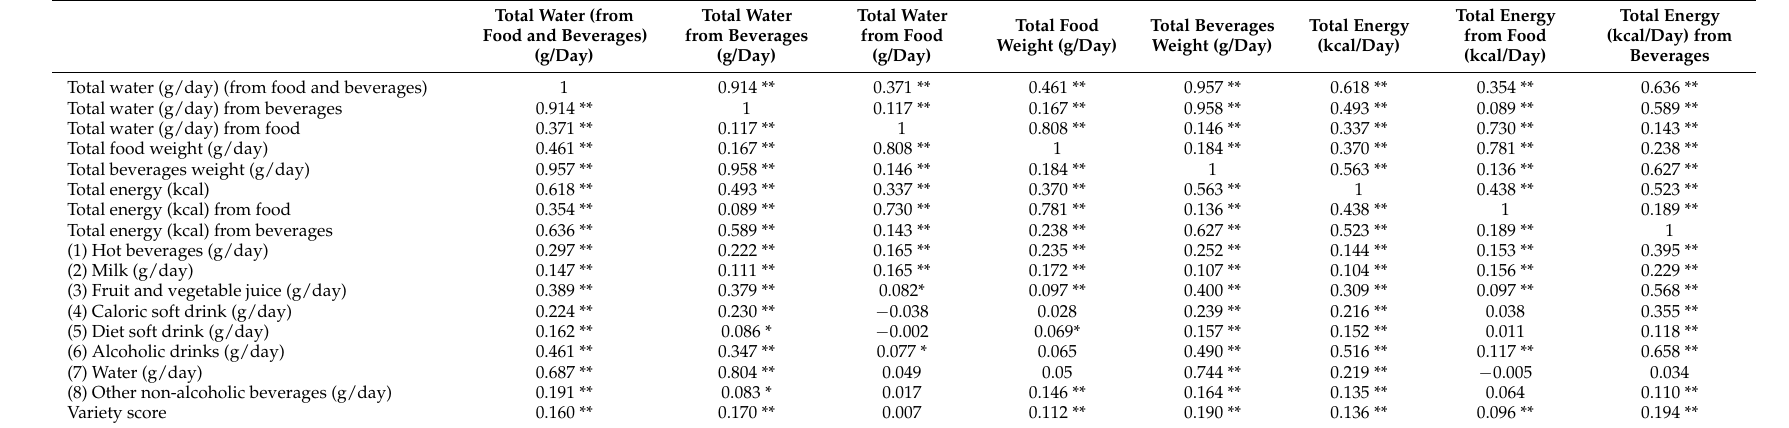
Table 4. Partial correlations between water intake, energy intake and beverage consumption adjusted for age, gender, body weight, and physical activity using the WBQ ( n =